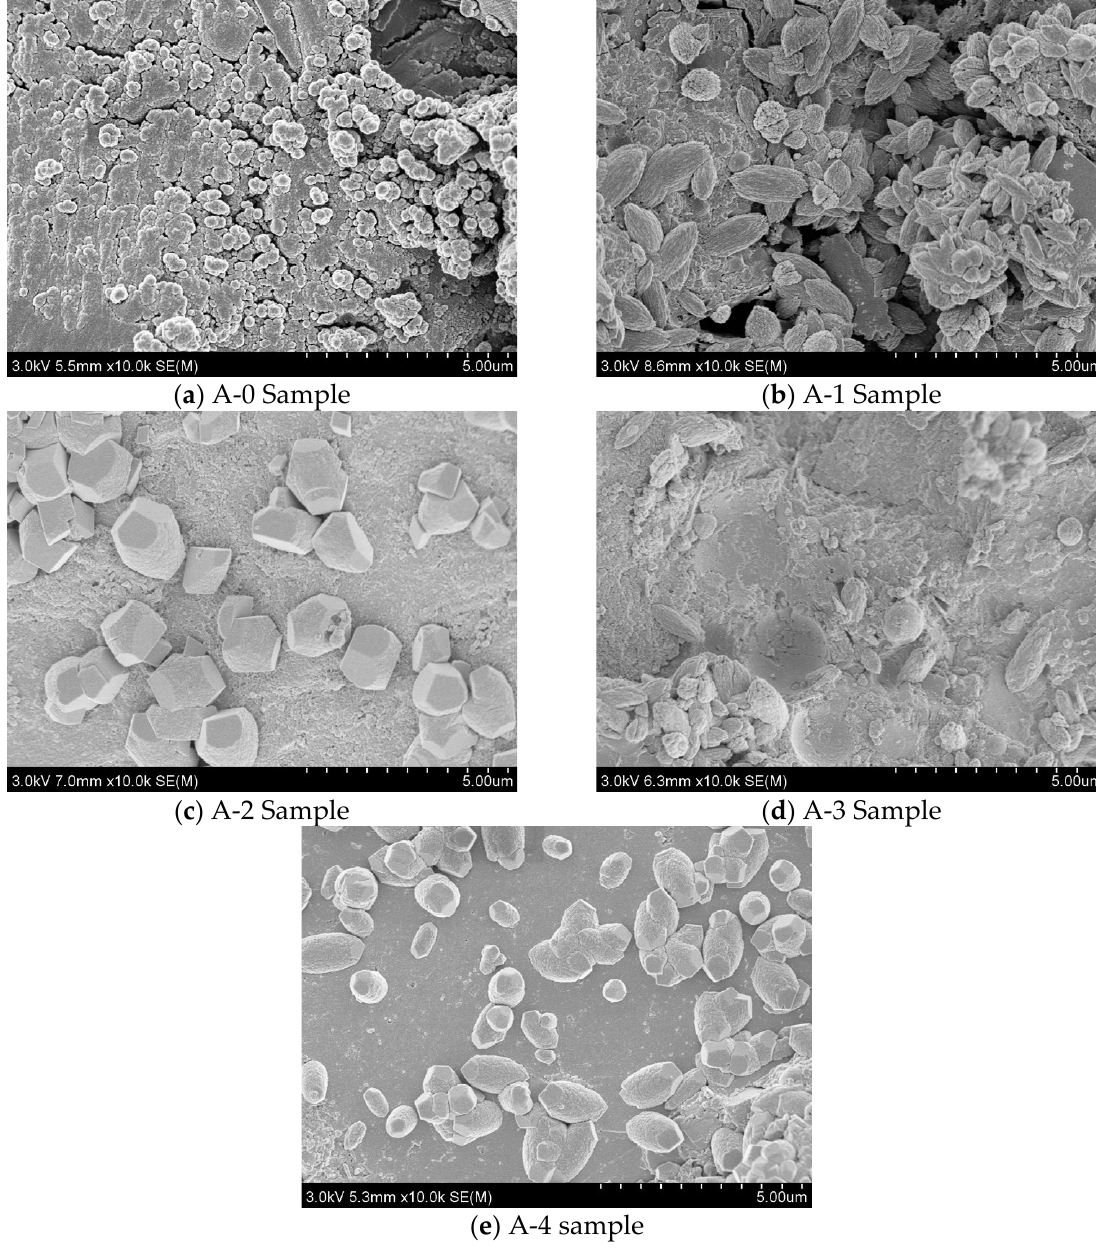
Figure 9. Three-day SEM photo of RPC sample.